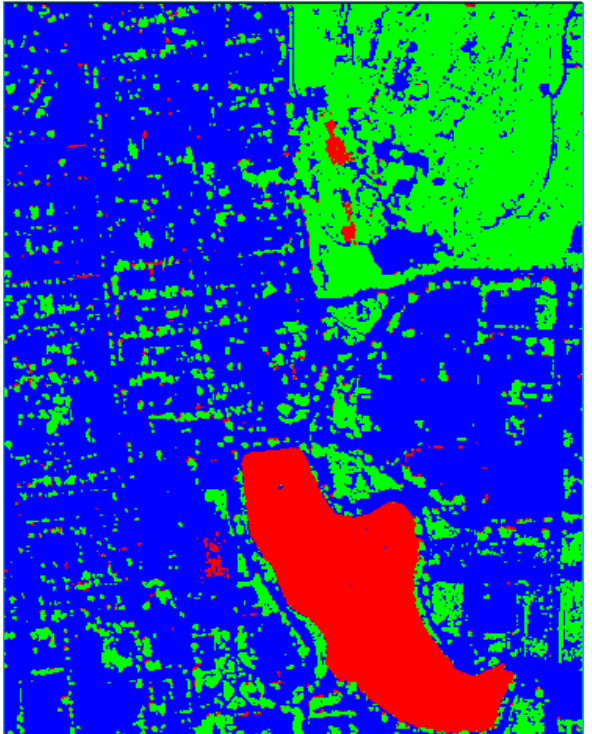
Figure 5. Classification result of maximum likelihood method